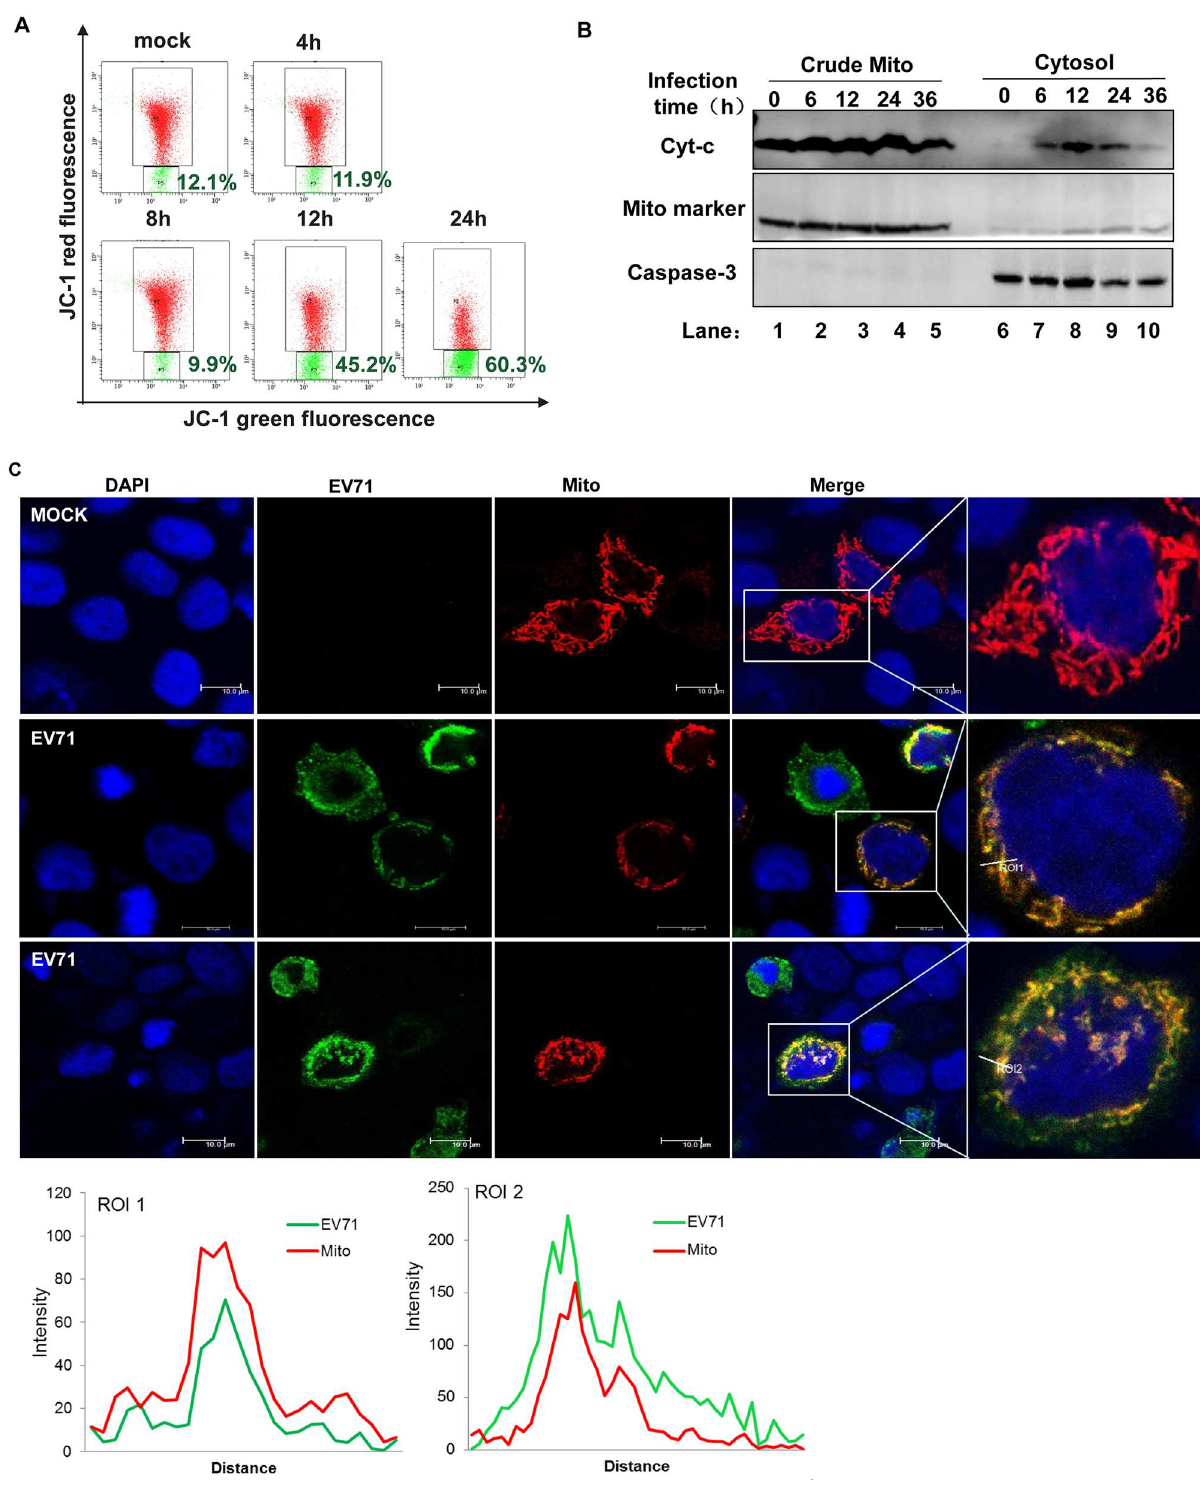
Fig 5. EV71 targets mitochondria to inhibit innate immunity. HeLa cells were infected with EV71 (MOI = 10) for the indicatedtime. (A) Mitochondrial membranepotentialwas analyzedby flow cytometry method using 5,5 0 ,6,6 0 -tetrachloro-1,1 0 ,3,3 0 -tetramethyl benzimidazolyl carbocyanine iodide(JC-1). The vertical and horizontal coordinatesrepresentedJC-1 red and green fluorescence, respectively. (B) Cells were subjectedto differential centrifugationto separate the crude mitochondrial (lanes1–5) from the cytosolic (lanes 6–10) compartment.